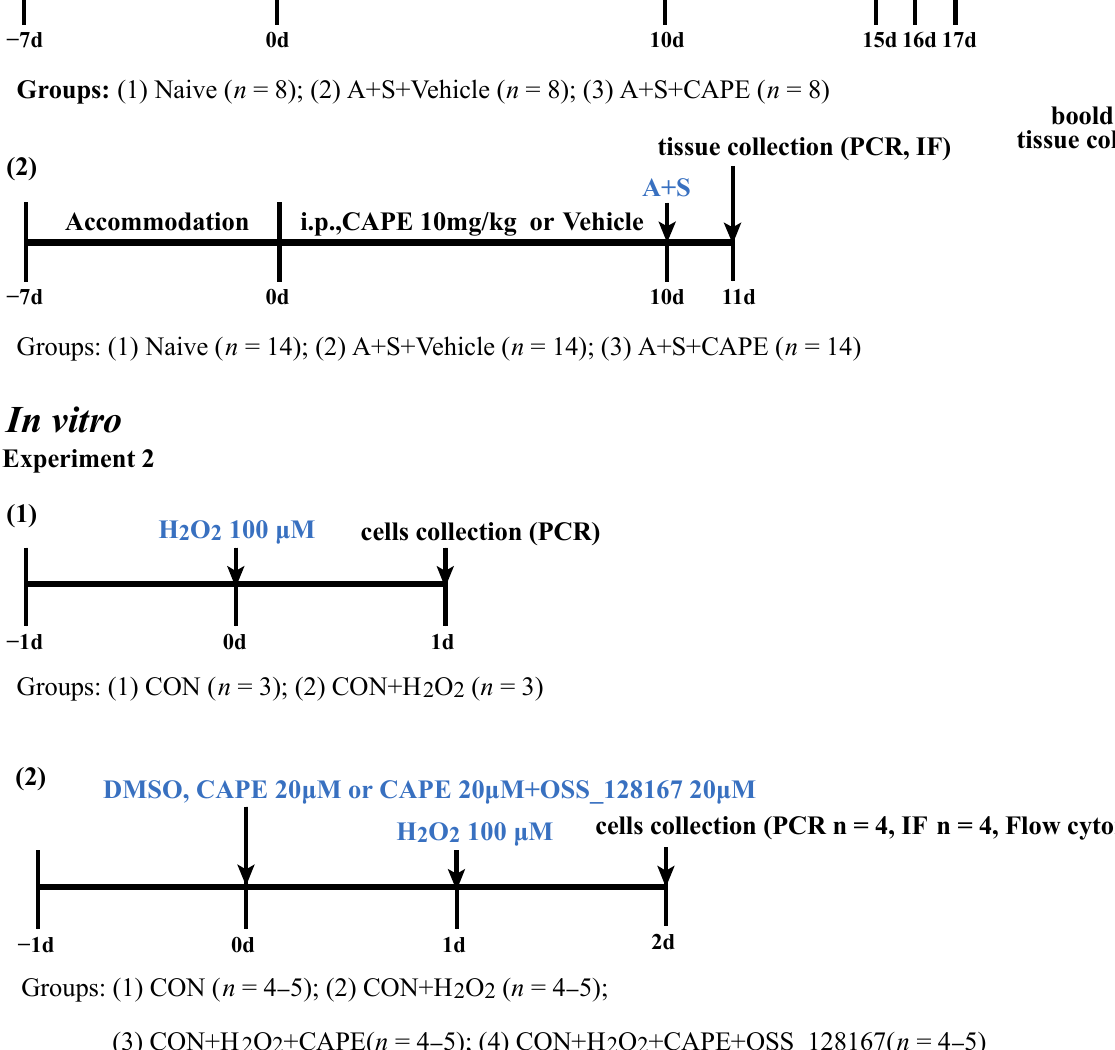
Figure 1. Schematic representation of the experimental procedure and grouping. Experiment 1: 20-month-old mice were pretreated with caffeic acid phenethyl ester (CAPE) or vehicle for 10 consecutive days, and then received or did not receive anesthesia and surgery. At 24 h after modeling, some of the mice were decapitated and tissue samples were collected for PCR and IF; the other mice were recovered in cages for 5 days, received behaviors assessment, and then their blood and tissue samples were collected. Experiment 2: BV2 cells were pretreated with DMSO, CAPE, or CAPE + OSS_128167 before incubating with H 2 O 2 . Subsequently, the BV2 cells were collected for PCR, IF, and flow cytometry.